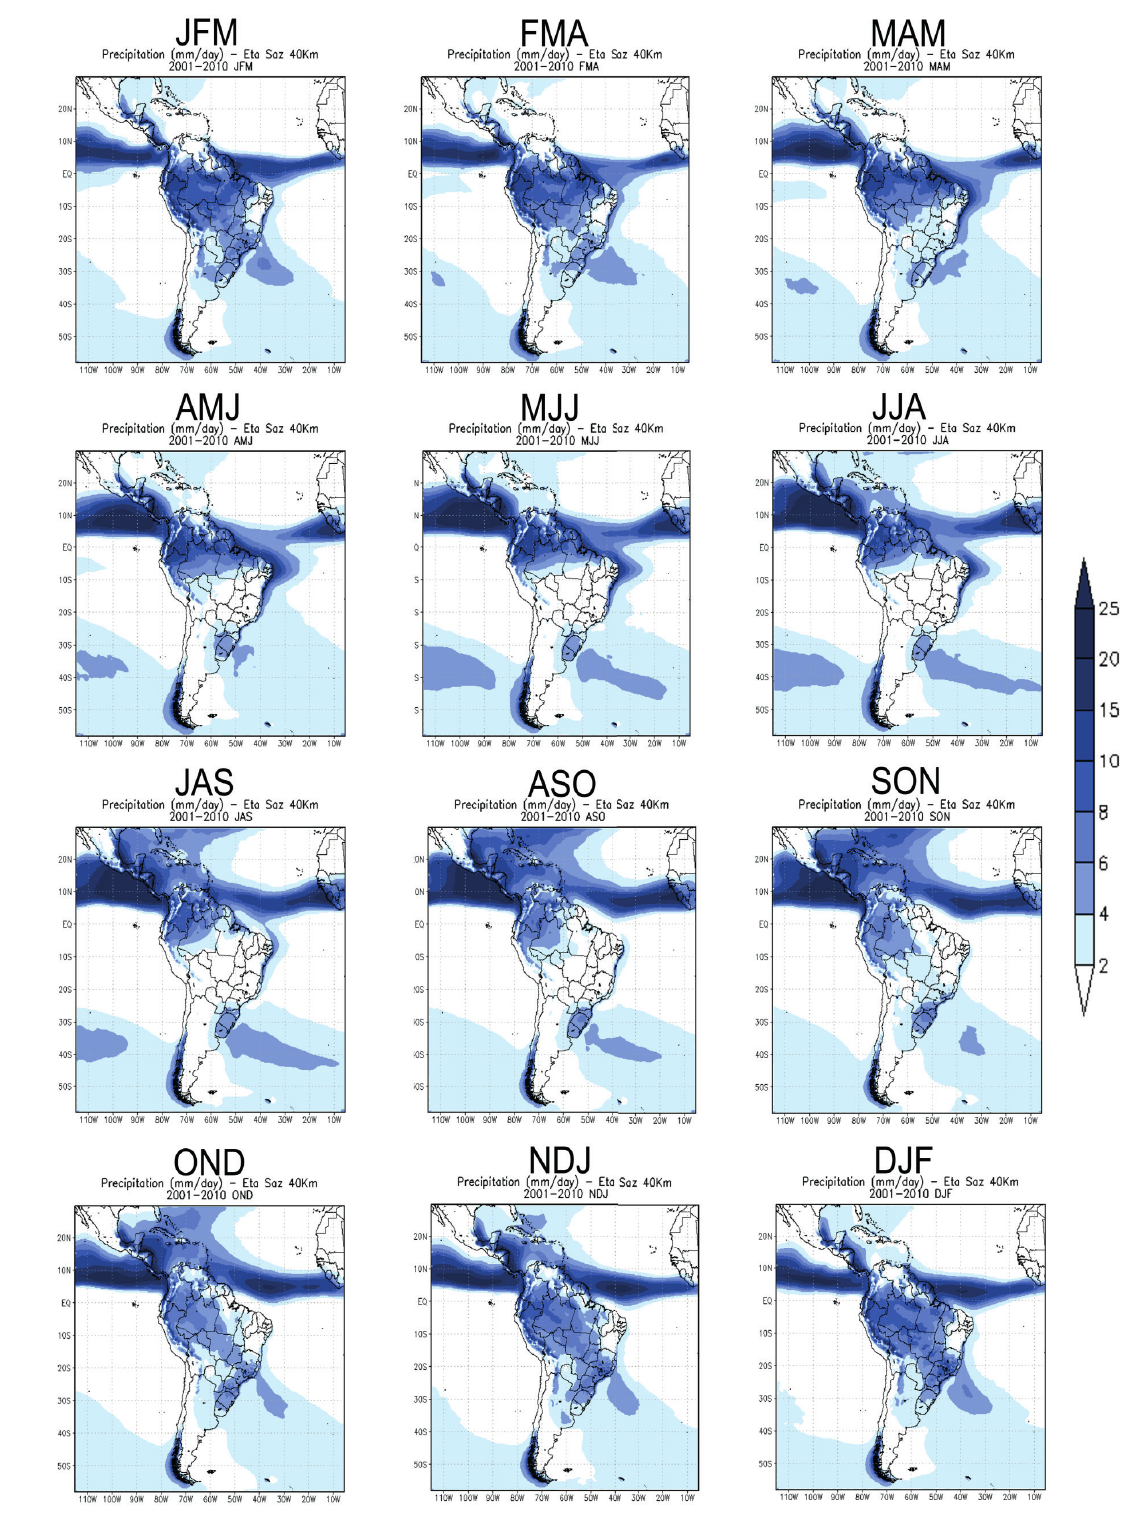
Figure 2. Seasonal mean precipitation (mm day -1 ) forecast by the Eta Regional Climate Model, averaged over the period 2001-2010 and the fi ve ensemble